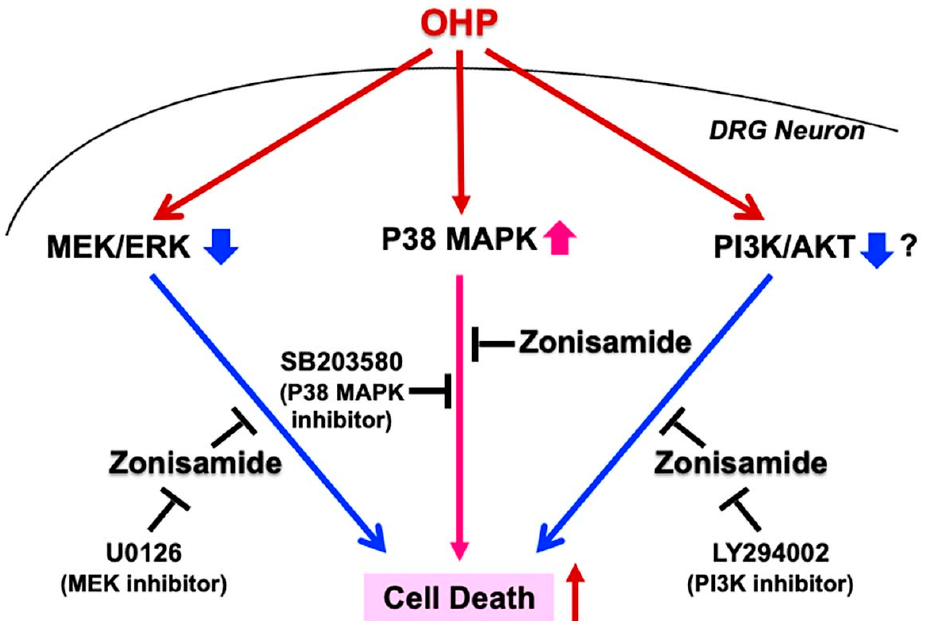
Figure 6. A schematic diagram showing the signaling pathways involved in the alleviating effects of zonisamide against OHP-induced DRG neuronal cell death based on the present